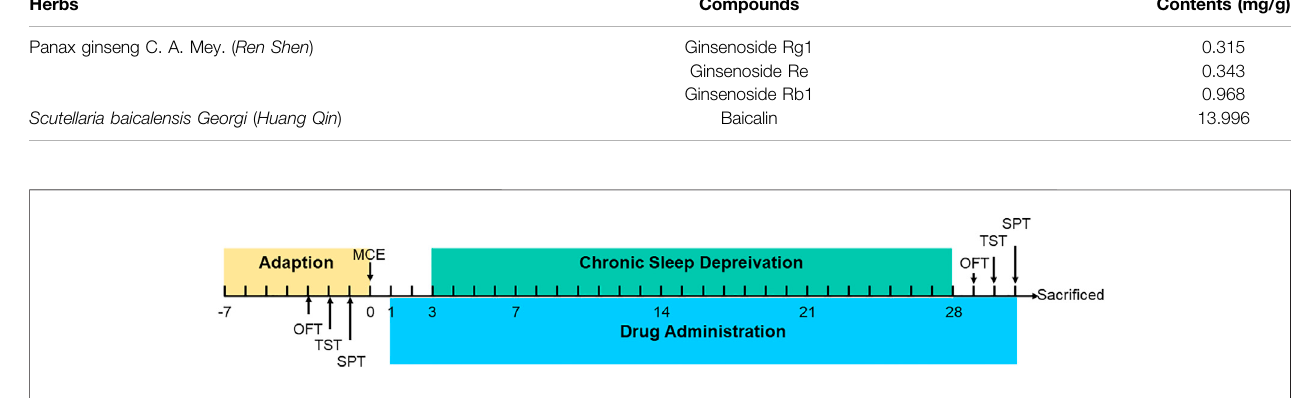
FIGURE 2 | Schedule of experimental procedures.